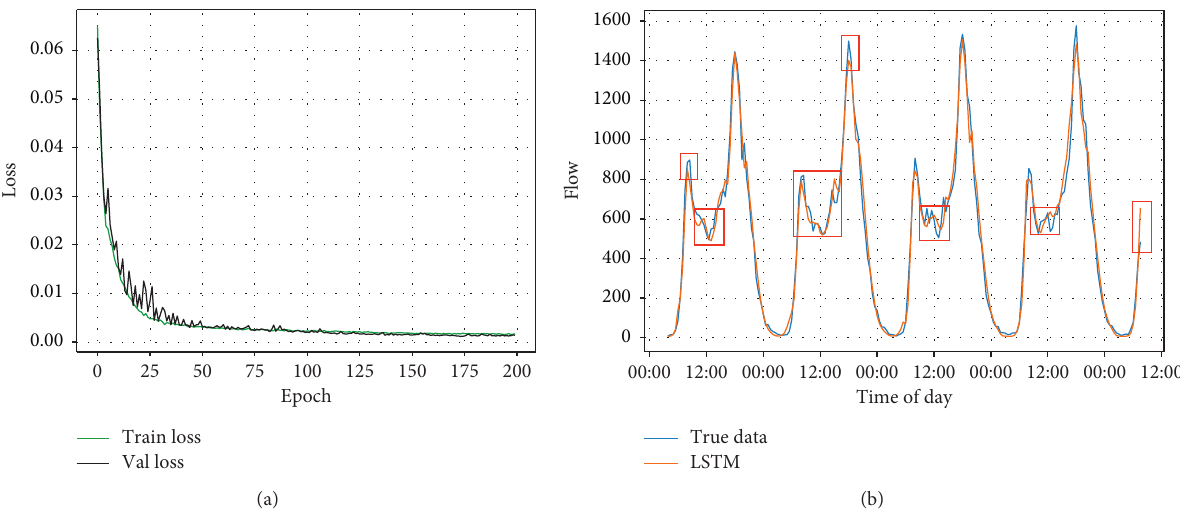
Figure 7: 30min LSTM training and prediction. (a) 30min LSTM loss function and (b) 30min LSTM prediction results.